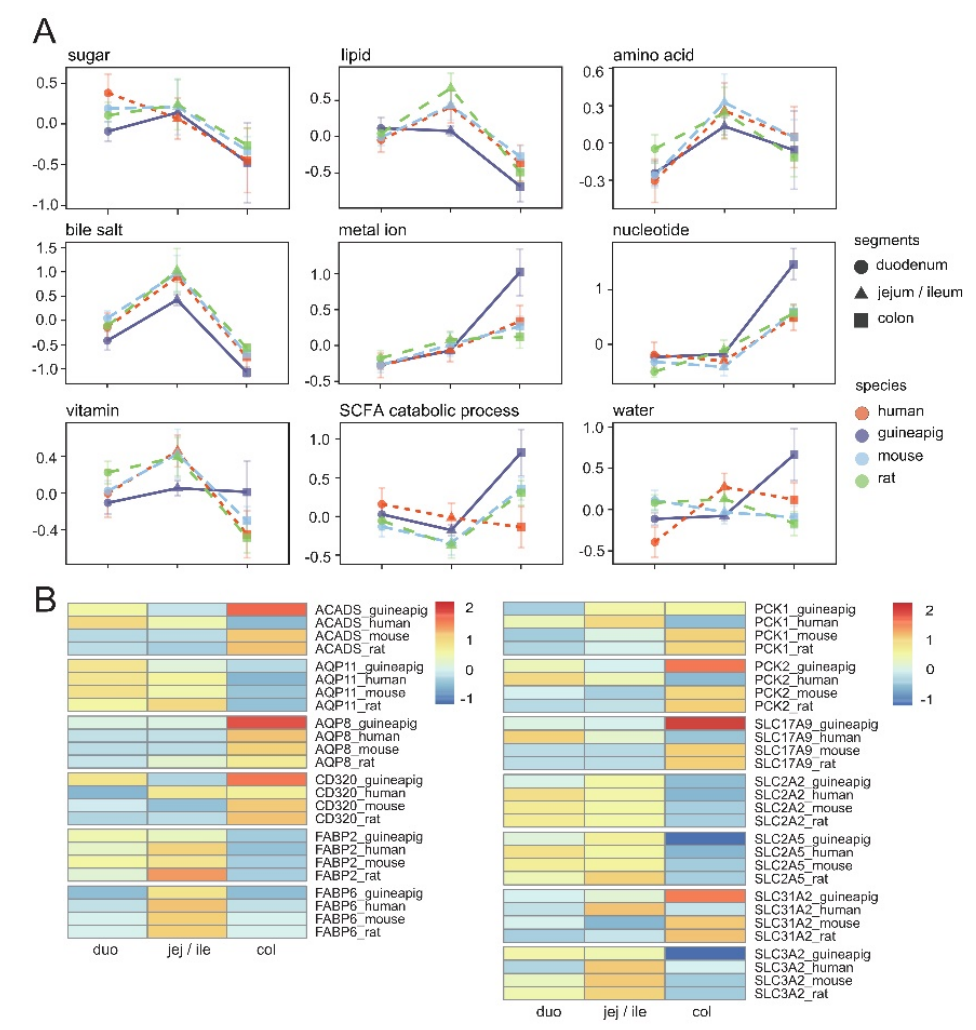
Figure 5. Gene expression differences in intestinal between species ( A ) Expression trend of fun-tional gene sets and ( B ) individual genes in different species. Duo: Duodenum; Jej/Ile: jejunum or ileum; Col: colon.